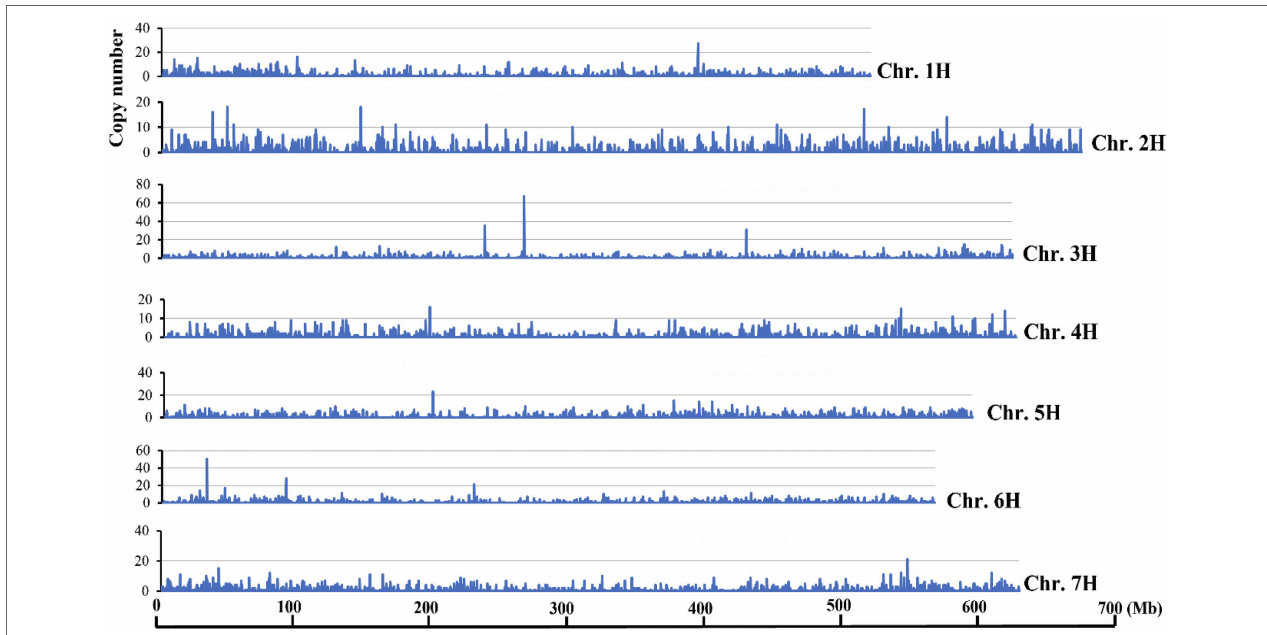
FIGURE 2 | Distributions of Hvu_Abermu transposons on seven barley